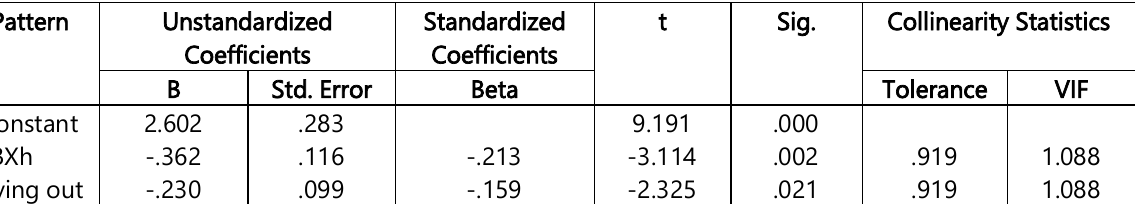
t Sig. Collinearity Statistics 9.191 .000 -3.114 .002 .919 1.088 -2.325 .021 .919